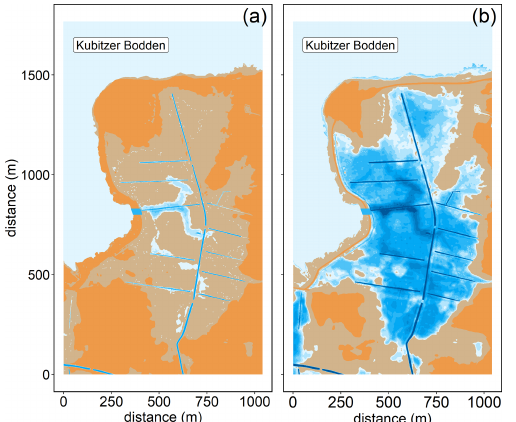
Figure A2. The changing water level and its effect on the water coverage of the study area is shown for (a) − 0.5ma.s.l. and (b) 0.5ma.s.l. To- pography data are retrieved from the Landesamt für innere Verwaltung Mecklenburg-Vorpommern, Amt für Geoinformation, Vermessungs- und Katasterwesen, Fachbereich Geodatenbereitstellung.